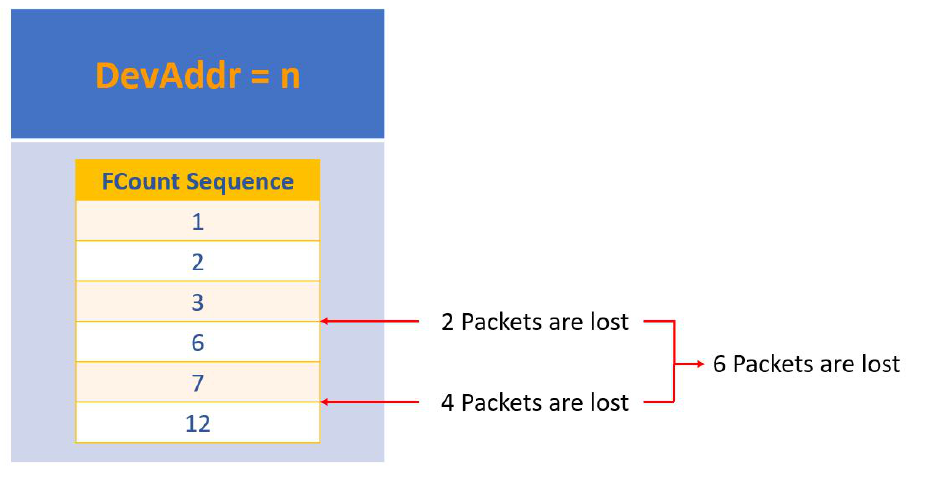
Figure 8. Scheme of the adopted strategy to compute the number of lost packets for a given